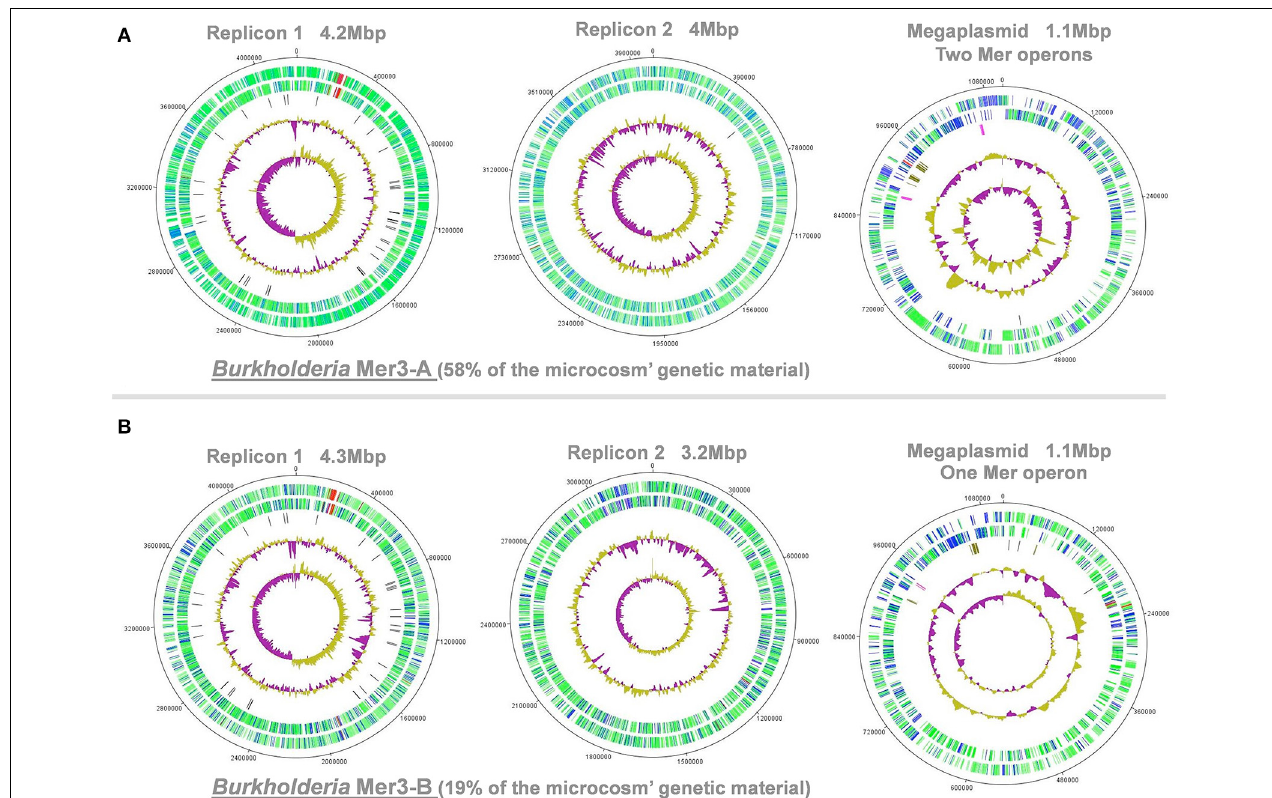
FIGURE 4 | Example of the two Burkholderia genomes reconstructed from the third replicate of mercury enrichment #2. Panels (A,B) represent replicons and mega-plasmid from Burkholderia Mer3-A and Mer3-B, respectively. Artemis and DNAPlotter were used to visualize the two replicons and mega-plasmid present in this microorganism. First (i.e., interior)